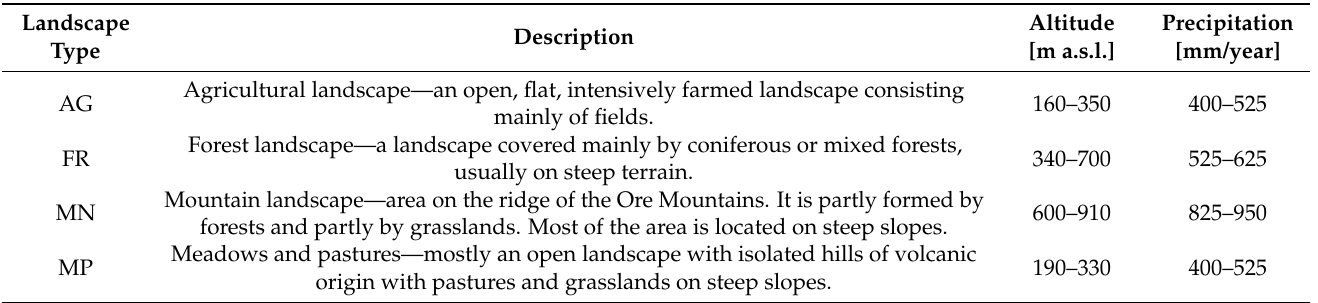
Table 1. Description of selected landscape types in the study area. Abbreviations of landscape types are explained within their